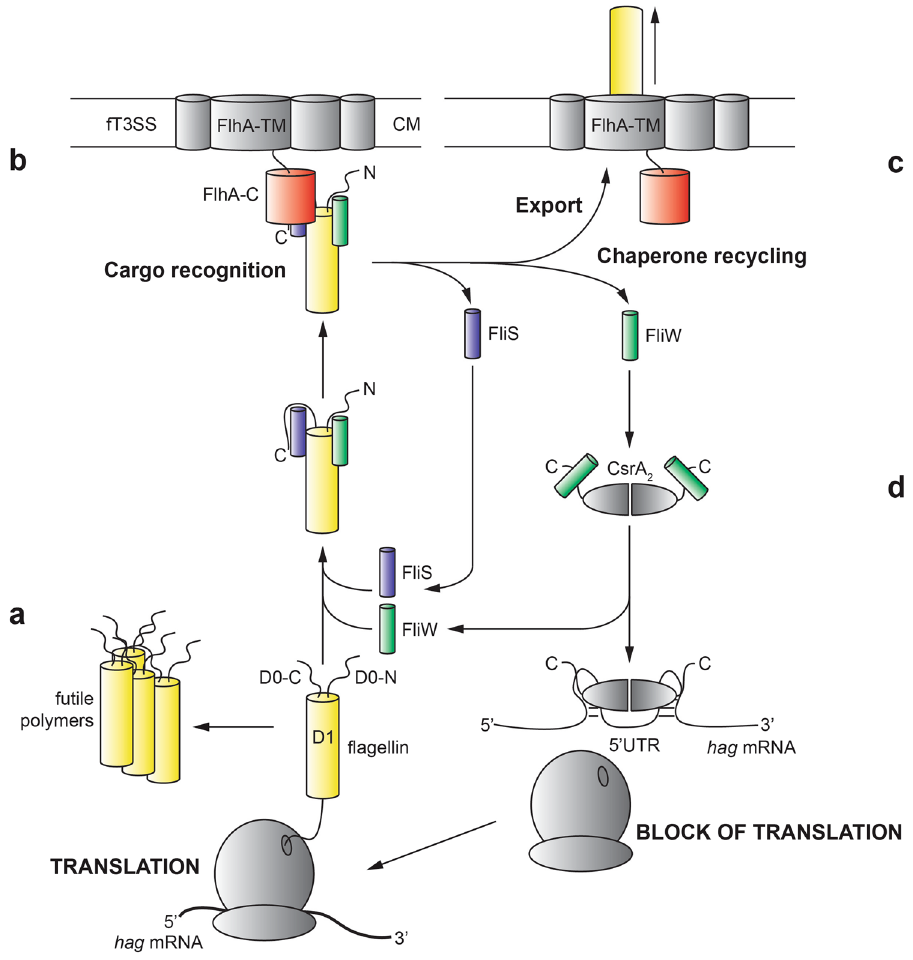
Figure 6. Model for coupling homeostasis and type-III-secretion of flagellin. The figure depicts how FliS, FliW and CsrA act in concert to couple flagellin homeostasis with its export by the fT3SS. Flagellin is shown in yellow, FliW in green, FliS in blue and FlhA-C in red. CsrA was not part of this study and is shown in grey. ( a ) FliS and FliW bind to flagellin once it has emerged from the ribosome to prevent formation of futile aggregates. ( b ) The FliS/flagellin/FliW complex is recognized by the type III secretion system via FlhA-C. ( c ) FliS and FliW are recycled after flagellin secretion. ( d ) Free FliW can sequester CsrA from the hag leader transcript, thereby allowing the next round of flagellin